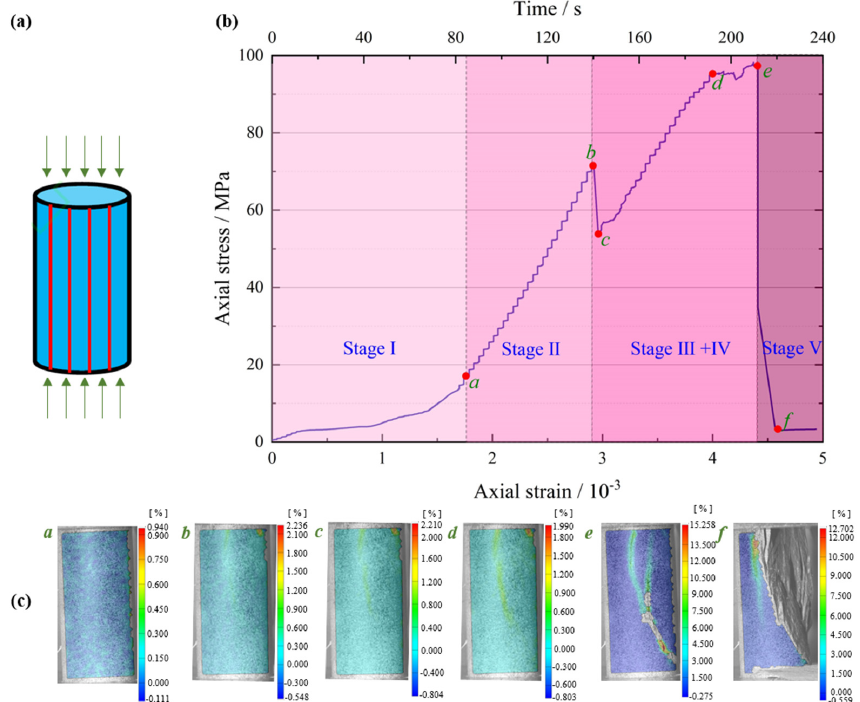
Figure 5. An entire crack evolution process of a typical foliated phyllite subjected to uniaxial compressive loading (S-W-90°): ( a ) Geometrical parameters and loading diagram of the specimen; ( b ) Axial stress–strain curves of a typical specimen; ( c ) The maximum principal strain fields under different loads stage.